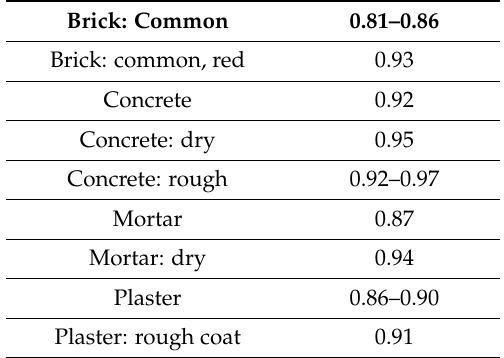
Figure 18. Discovered weak point heat bridge. In order to determine the existence of discontinuity in the outer envelope, heating was applied, as is shown in Figure 19. Figure 19. Initial application moment of thermal excitation. There was not any discontinuity by the analysis of the thermal pattern change. In Figure 20, a linear trace of the heating body, which is continuous and uninterrupted, can be observed. Figure 20. Homogeneous thermal pattern on excitation along the wall. The detail below the left window in the lower left corner of the thermogram reveals that spot facade damage, due to a difference in emissivity, shows a higher apparent temperature (Figure 21).